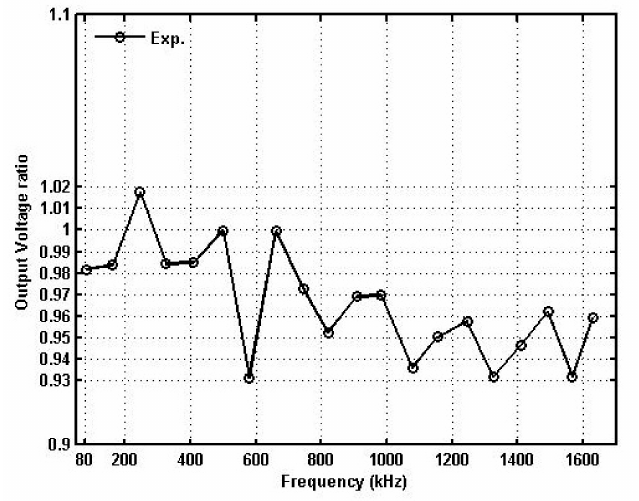
Figure 24. The measured amplitude ratio of the quadrature output voltages V o1 and V o2 versus the tuning